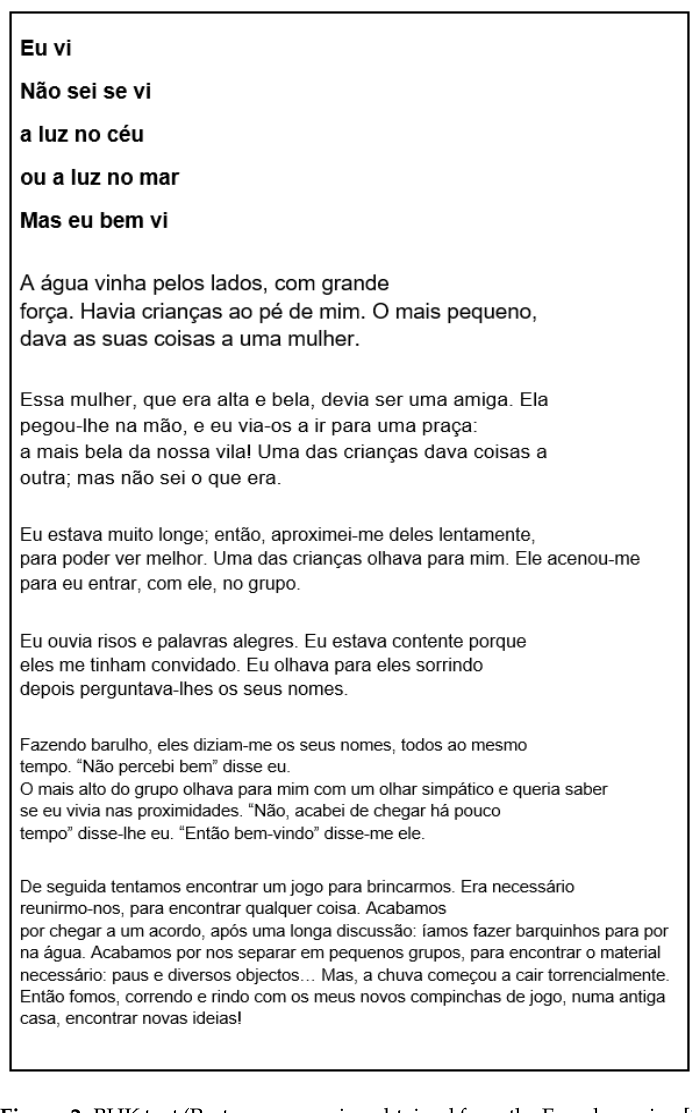
Figure 3. Handwriting example of the BHK text (Portuguese version is shown in Figure 2 and the English translation is shown in Appendix A) copied for 5 min by a participant on a blank A4 sheet